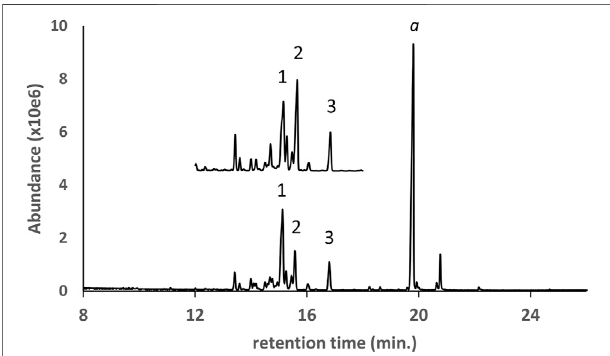
FIGURE5| GC-MSchromatogramforad9THCvapingliquid(peaklabel a, lower trace ) in which a series of pine rosin acid methyl esters were identi fi ed, compared to a standard mix ( upper trace , offset, condensed scale)ofapartiallyhydrogenatedmethylesterrosinatereferencematerial with a methyl abietate standard. The predominant esters were identi fi ed as methyl dihydroabietate, methyl dehydroabietate, and methyl abietate (peak labels 1 – 3,